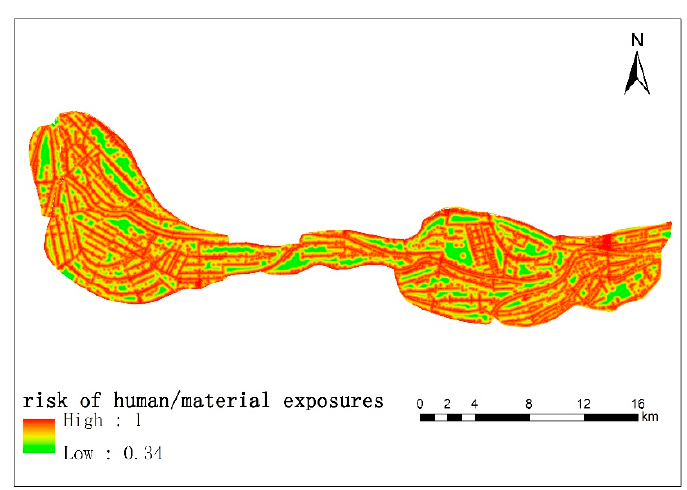
/ material exposures.